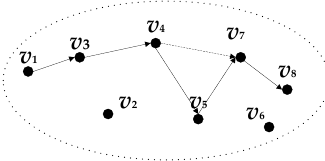
Figure 1. Packet-forwarding path in a community without a core